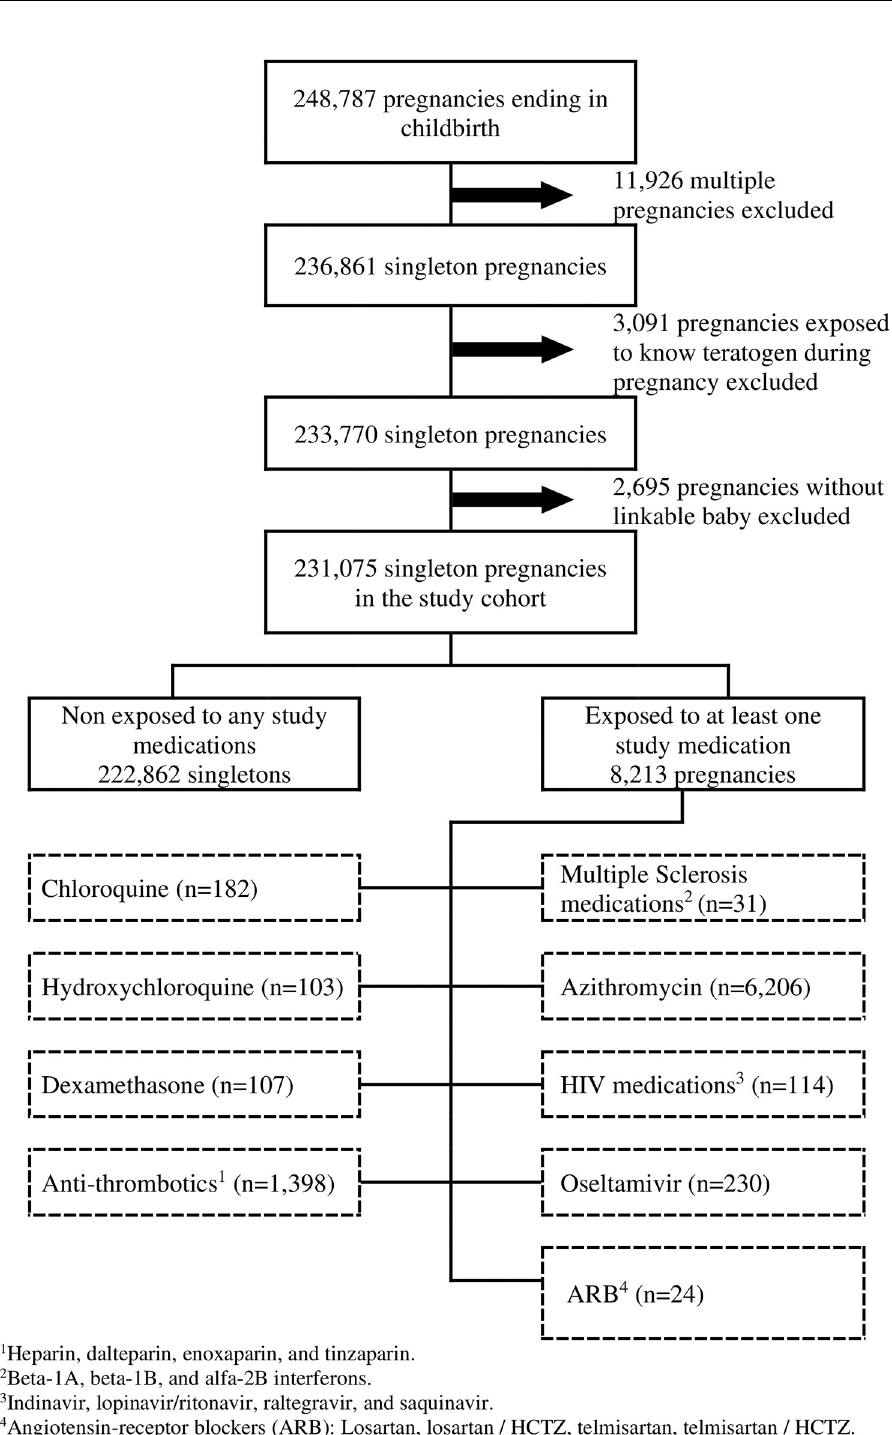
Fig 1. Cohort selection within the Quebec Pregnancy